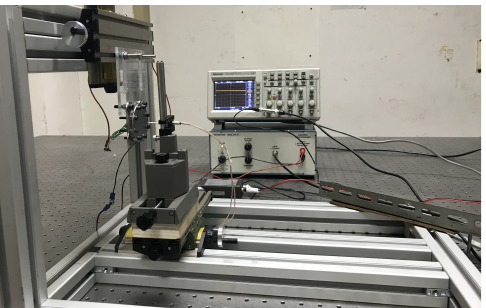
Figure 3. View of the experimental setup for the hot-wire anemometry